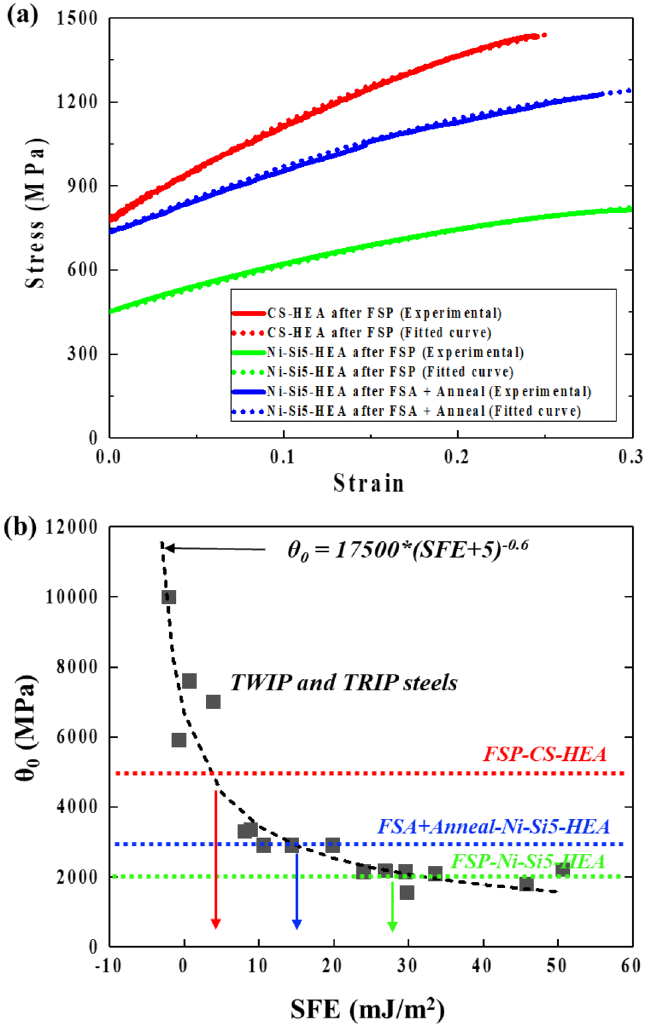
Figure 6. ( a ) Experimental stress–strain curves of CS–HEA and Ni–Si5–HEA in different conditions, ( b ) Correlations of θ 0 and SFE for TRIP and TWIP